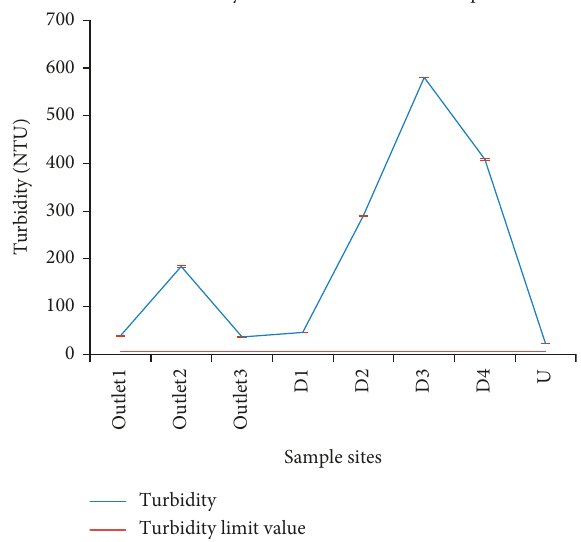
Figure 4: Comparison of the turbidity of wastewater from the Zenzelma campus and the maximum turbidity limit value for drinking water.